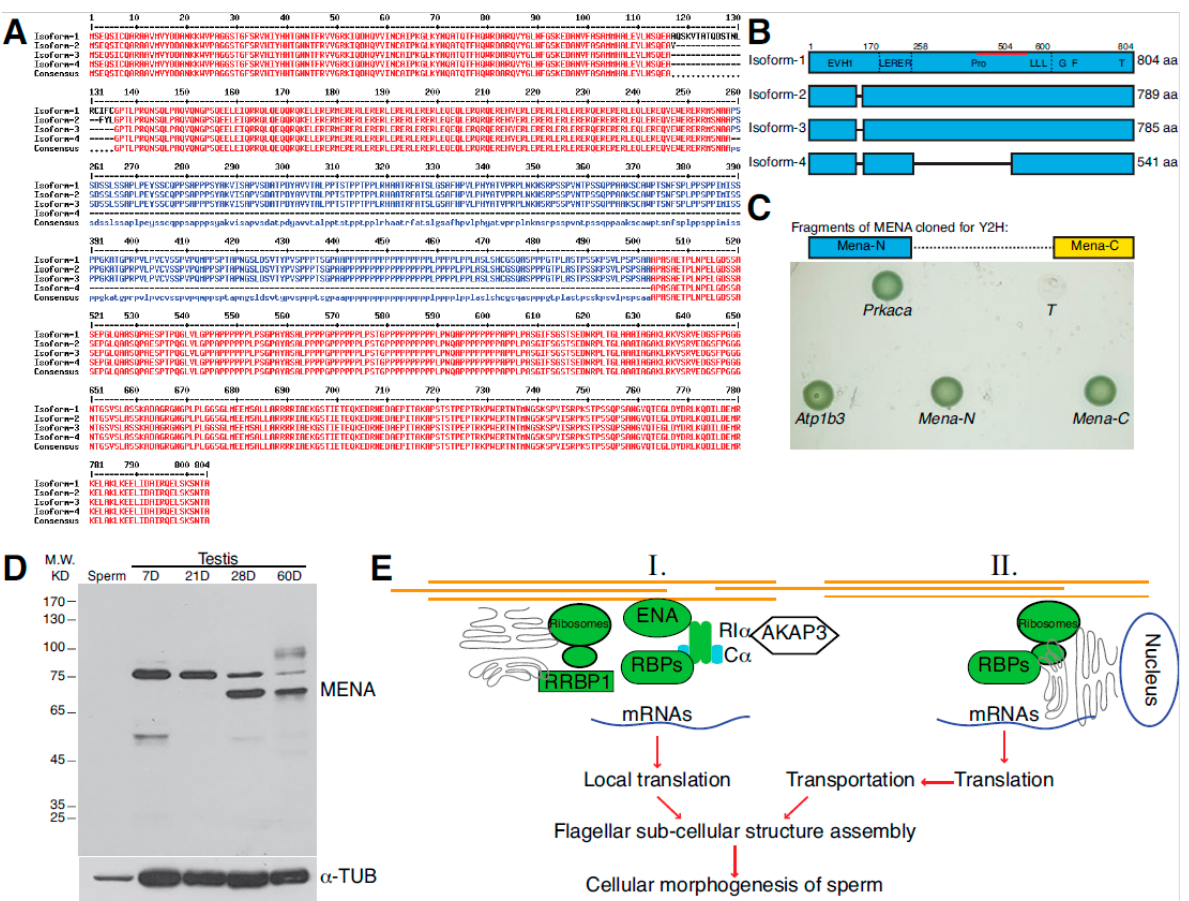
Figure 3. Interaction of PKA-RI α and MENA isoform expressed during mouse spermiogenesis. ( A ) Sequence alignment of MENA isoforms. The short isoform 4 lacks 244 internal amino acids compared to the other three isoforms. ( B ) Domain representation of MENA. MENA contains multiple domains that interact with various proteins. EVH1: EVH1 domain; LERER: LERER repeats; Pro: proline-rich domain; L: loading poly-proline; G: G-actin-binding site; F: F-actin-binding site; T: tetramerization site. Red line: aa415-541, a region used as the antigen for generating mouse monoclonal anti-MENA used in ( D ). ( C ) Y2H of MENA fragments. Schematics showing the fragments of MENA separated during cDNA sub-cloning (upper panel). The results show that PKA-RI α was able to interact with both the N0 and C-terminal halves of MENA (lower panel). ( D ) Western blotting of mouse testis lysates. Testes from mice at various ages were lysed and subjected to immunoblotting with anti-MENA. ( E ) A model showing protein synthesis during mouse spermiogenesis that is potentially regulated by PKA-I via interactions with MENA- and RNA-binding proteins. Proteins may be synthesized locally or near the nucleus and then transported along developing flagella to facilitate cellular morphogenesis.